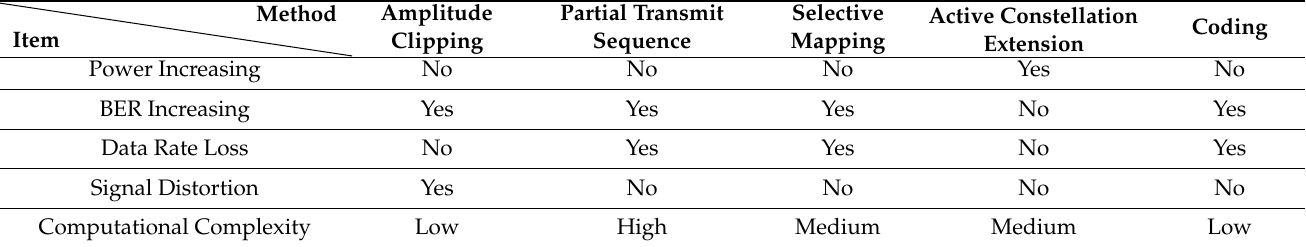
Table 1. Summary on comparison of various PAPR reduction schemes. Peak-to-average power ratio (PAPR).